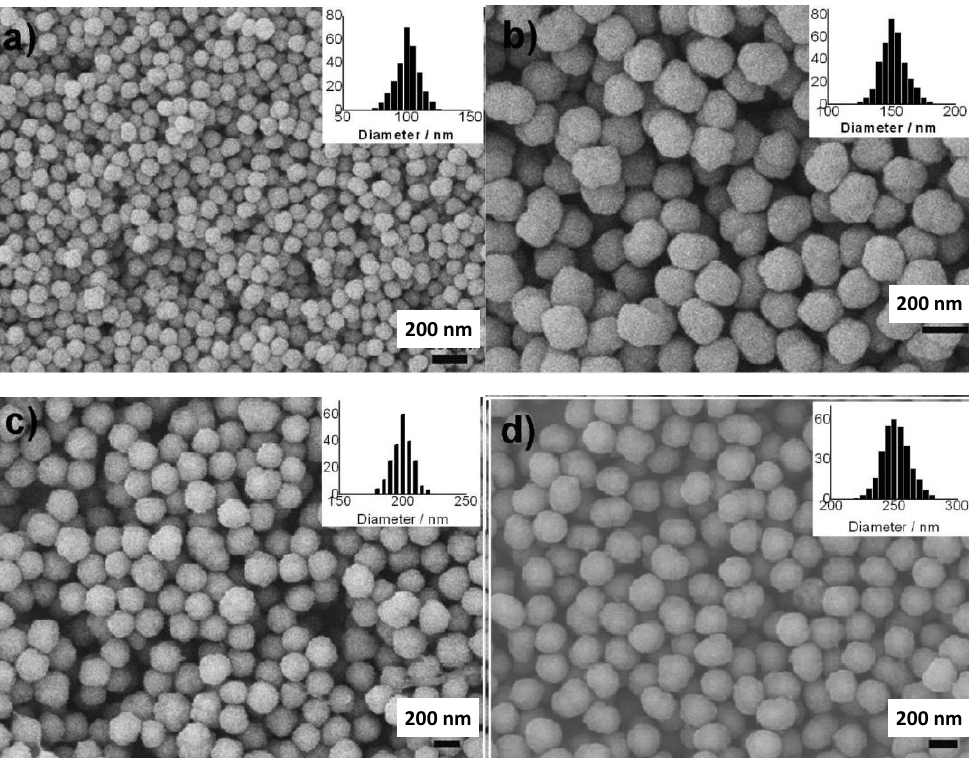
Figure 9. SEM micrographs of SPM multi-core Fe 3 O 4 @C spheres developed by a solvothermal technique with di ff erent amounts of hydrogen peroxide ( a ) 0.50, ( b ) 1.00, ( c ) 1.50, and ( d ) 2.00 mL, ensuring size control ( a ) 100, ( b ) 150, ( c ) 200, and ( d ) 250 nm. (Images reprinted with permission from [45], ACS, 2011).